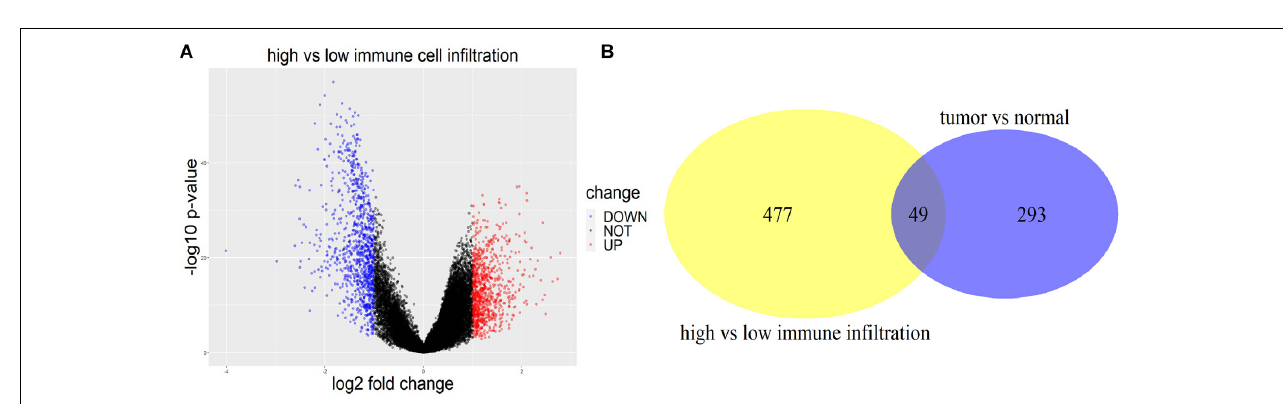
FIGURE 1 | High and low immune-cell-infiltrated groups. (A) The GSEA scores for 28 types of immune cells from GSVA package using ssGSEA method. Red represented high GSEA score for high immune cell infiltration, blue represented low GSEA score for low immune cell infiltration. (B) The stromal score, immune score, and ESTIMATE score for high and low immune-cell-infiltrated groups.